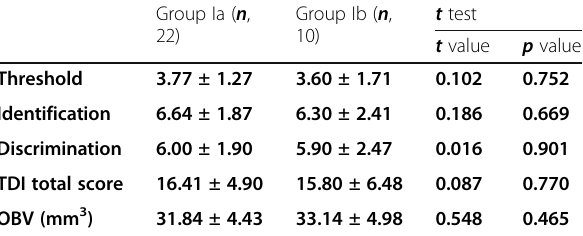
Table 2 Statistical analysis of Sniffin Stick test and olfactory bulb volumetry among tremor dominant (group Ia) and postural instability gait difficulty (group Ib) variants of Parkinson disease